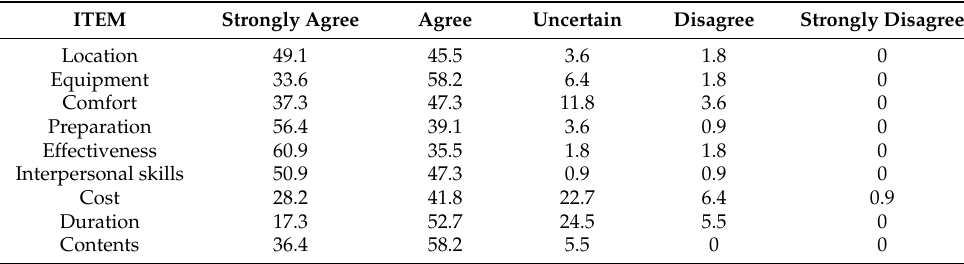
Table 5. Percentages of response for each sub-criterion.